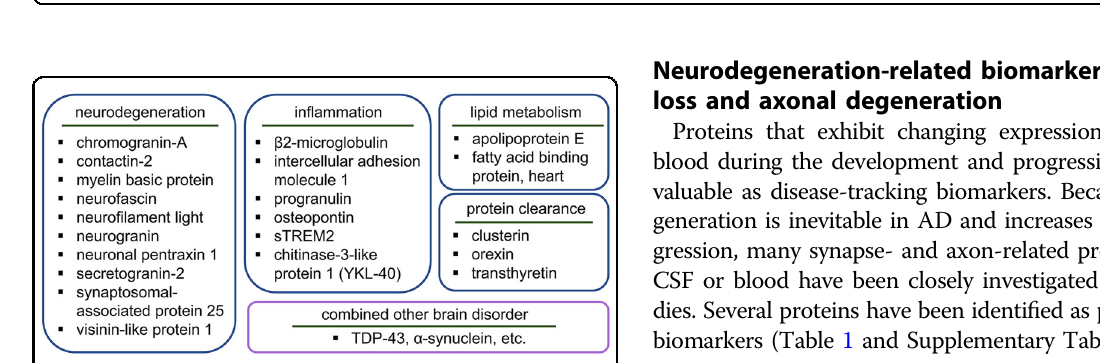
Fig. 1 Overview of the pathophysiological process in Alzheimer ’ s disease. BBB, blood – brain barrier; CSF, cerebrospinal fl uid.